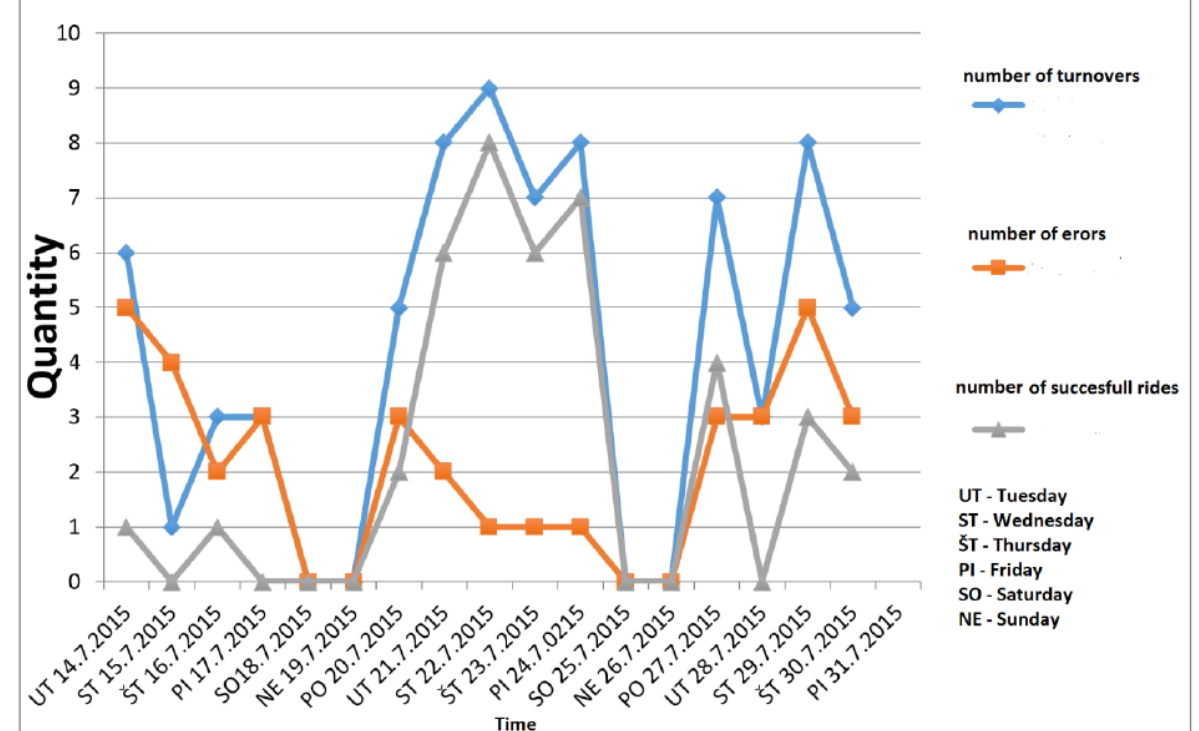
Figure 9: Errors in the AGV train